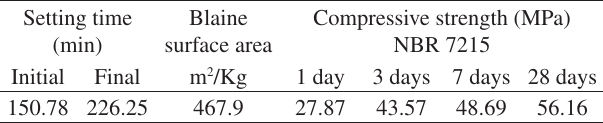
Table 2. Physical properties of cement obtained from the producer. obtained from the producer.. Setting time (min)